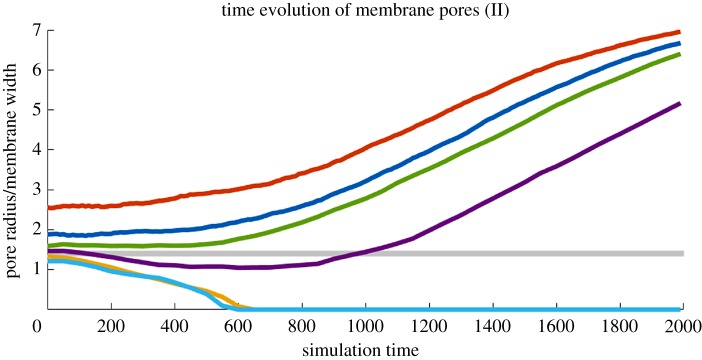
Membrane pore size over time as calculated by equation (3.1). Size (y axis) is shown in units of the average membrane width, h = 7.98. Several initial sizes are shown, ranging from r0/h = 1.21 (bottom) to r0/h = 2.56 (top). The shaded region denotes possible values of the critical ratio rc/h below which pores seal, 1.34 < rc/h < 1.47.